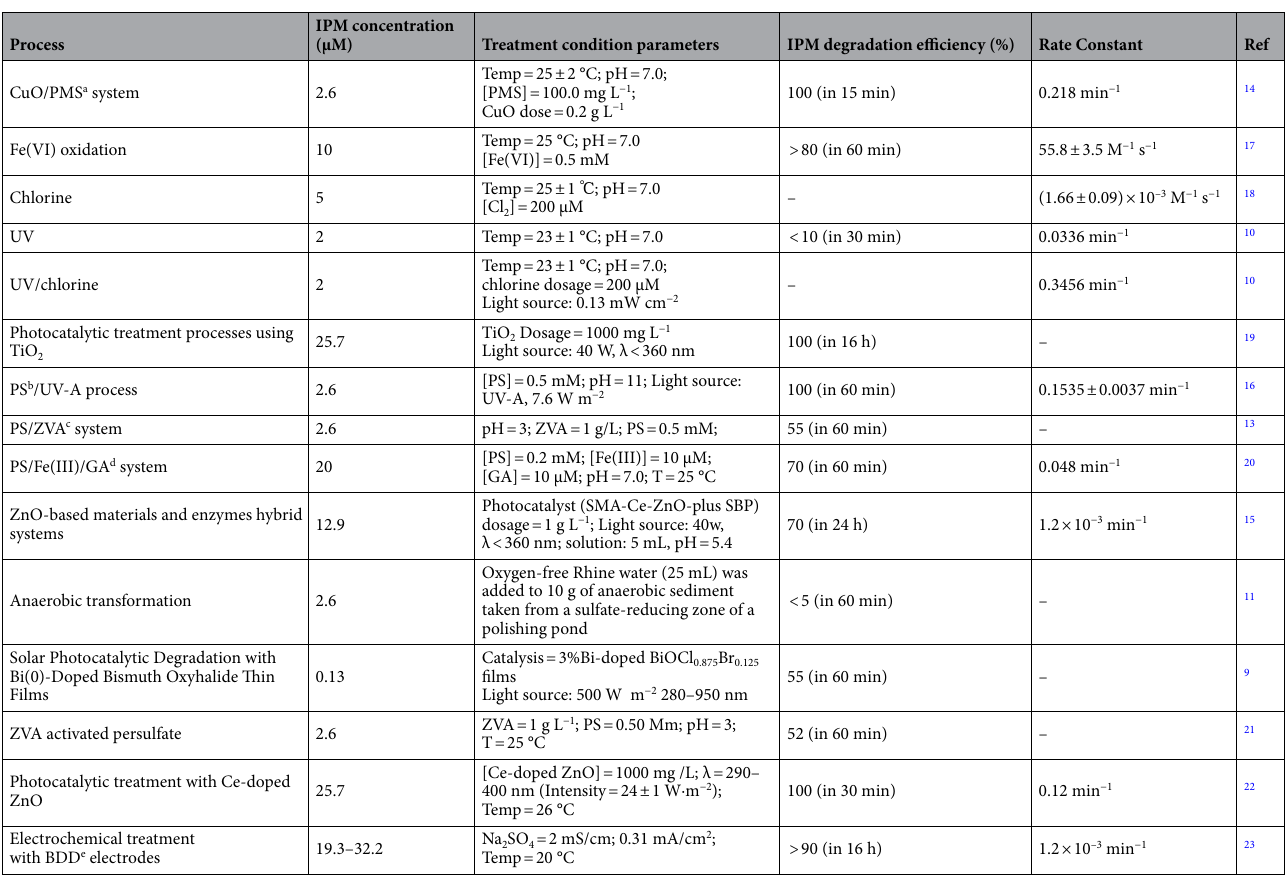
Table 1. IPM main treatment process (2016–2018). a. PMS = Peroxymonosulfate. b. PS = Persulfate. c. ZVA = Zero-valent Aluminum. d. GA = Gallic acid. e. BDD = Boron-doped diamond (BDD)